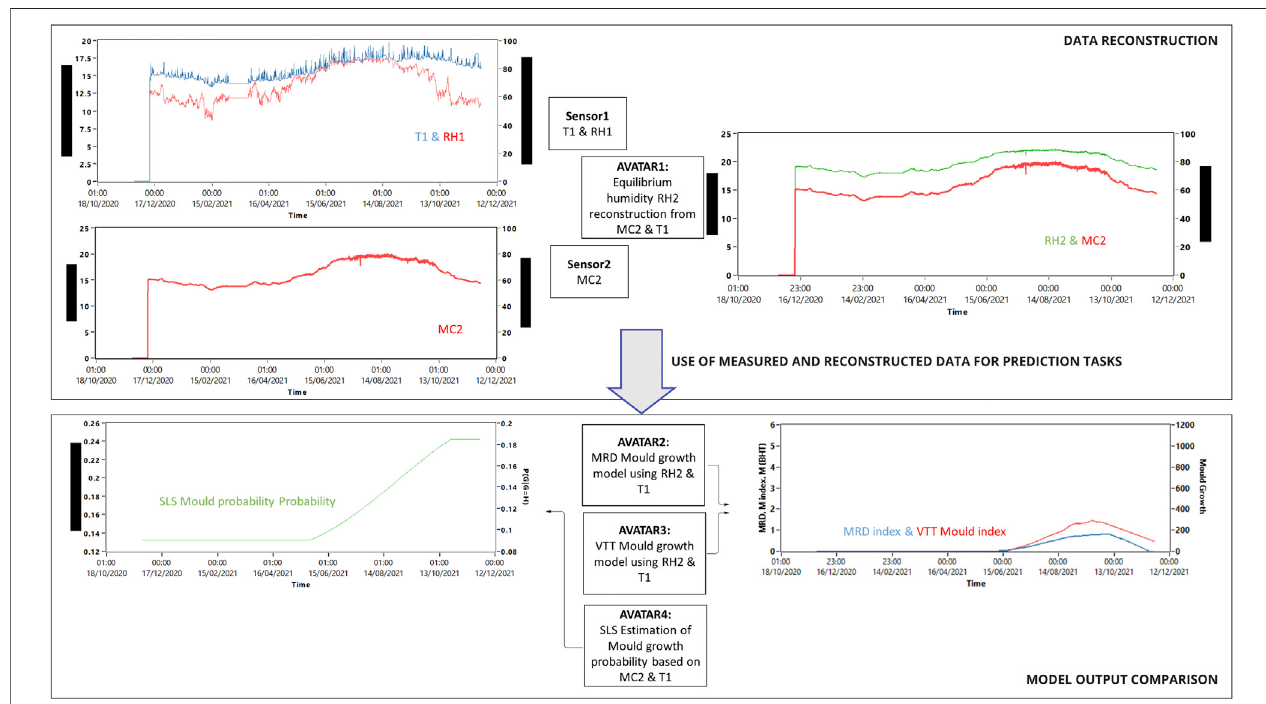
FIGURE 2 | Hygrothermal data reconstruction and alternative mold risk prediction scenarios provided by an avatar network.